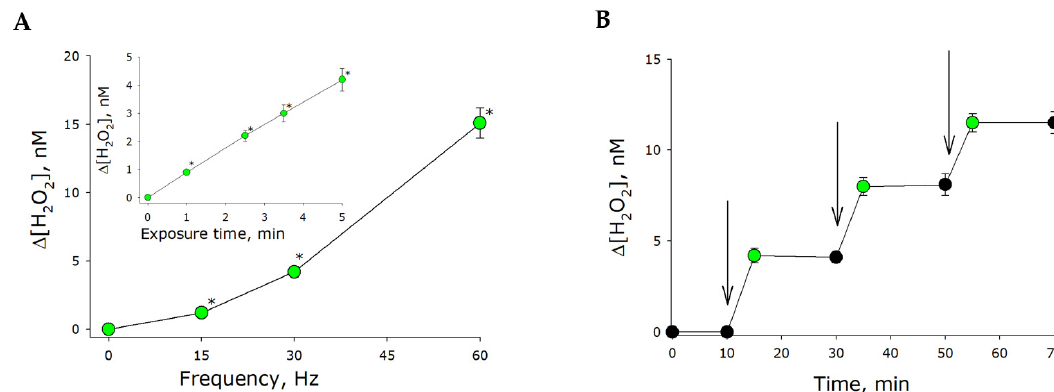
Figure 5. The effect of mechanical stress on hydrogen peroxide concentration in water. ( A ) The effect of frequency of mechanical stress on hydrogen peroxide concentration (amplitude of 5 mm, exposure time of 5 min). The insert displays the effect of exposure time on hydrogen peroxide concentration (30 Hz, amplitude of 5 mm). ( B ) Changes in hydrogen peroxide concentration following multiple mechanical stresses. The time of a single exposure was 5 min, with the frequency and amplitude of 30 Hz and 5 mm, respectively. The intervals during which mechanical stress was applied are indicated with vertical errors. The data are presented as the mean and standard error of the mean for six independent assays. Data differ significantly from control values at p < 0.05 (*).